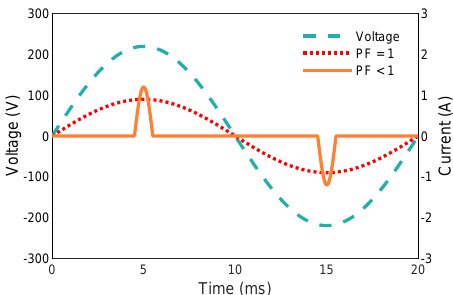
Figure 3. Effect of current waveform on power factor.